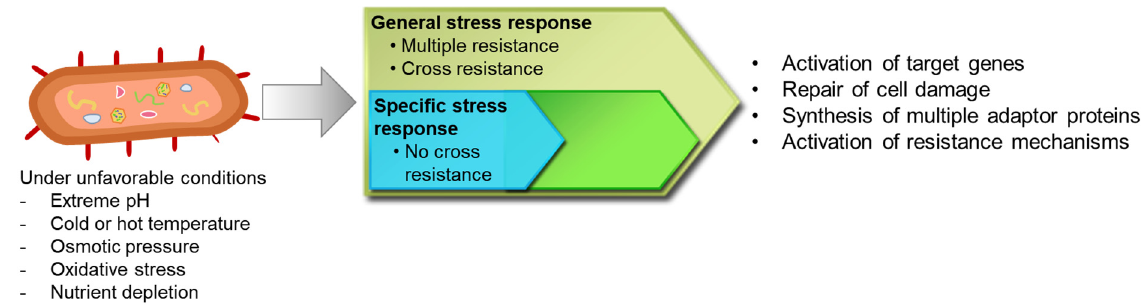
Figure 2. General and specific stress response regulation in bacteria.